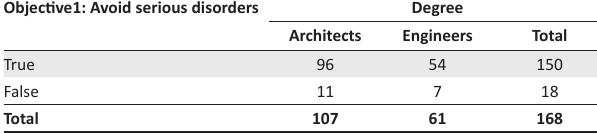
TABLE 6: Objective 1 of seismic rules (avoid serious disorders).